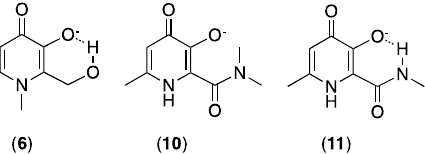
Figure 4. Intramolecular hydrogen bonding can stabilise ionised hydroxyl groups of 3,4-HPs.